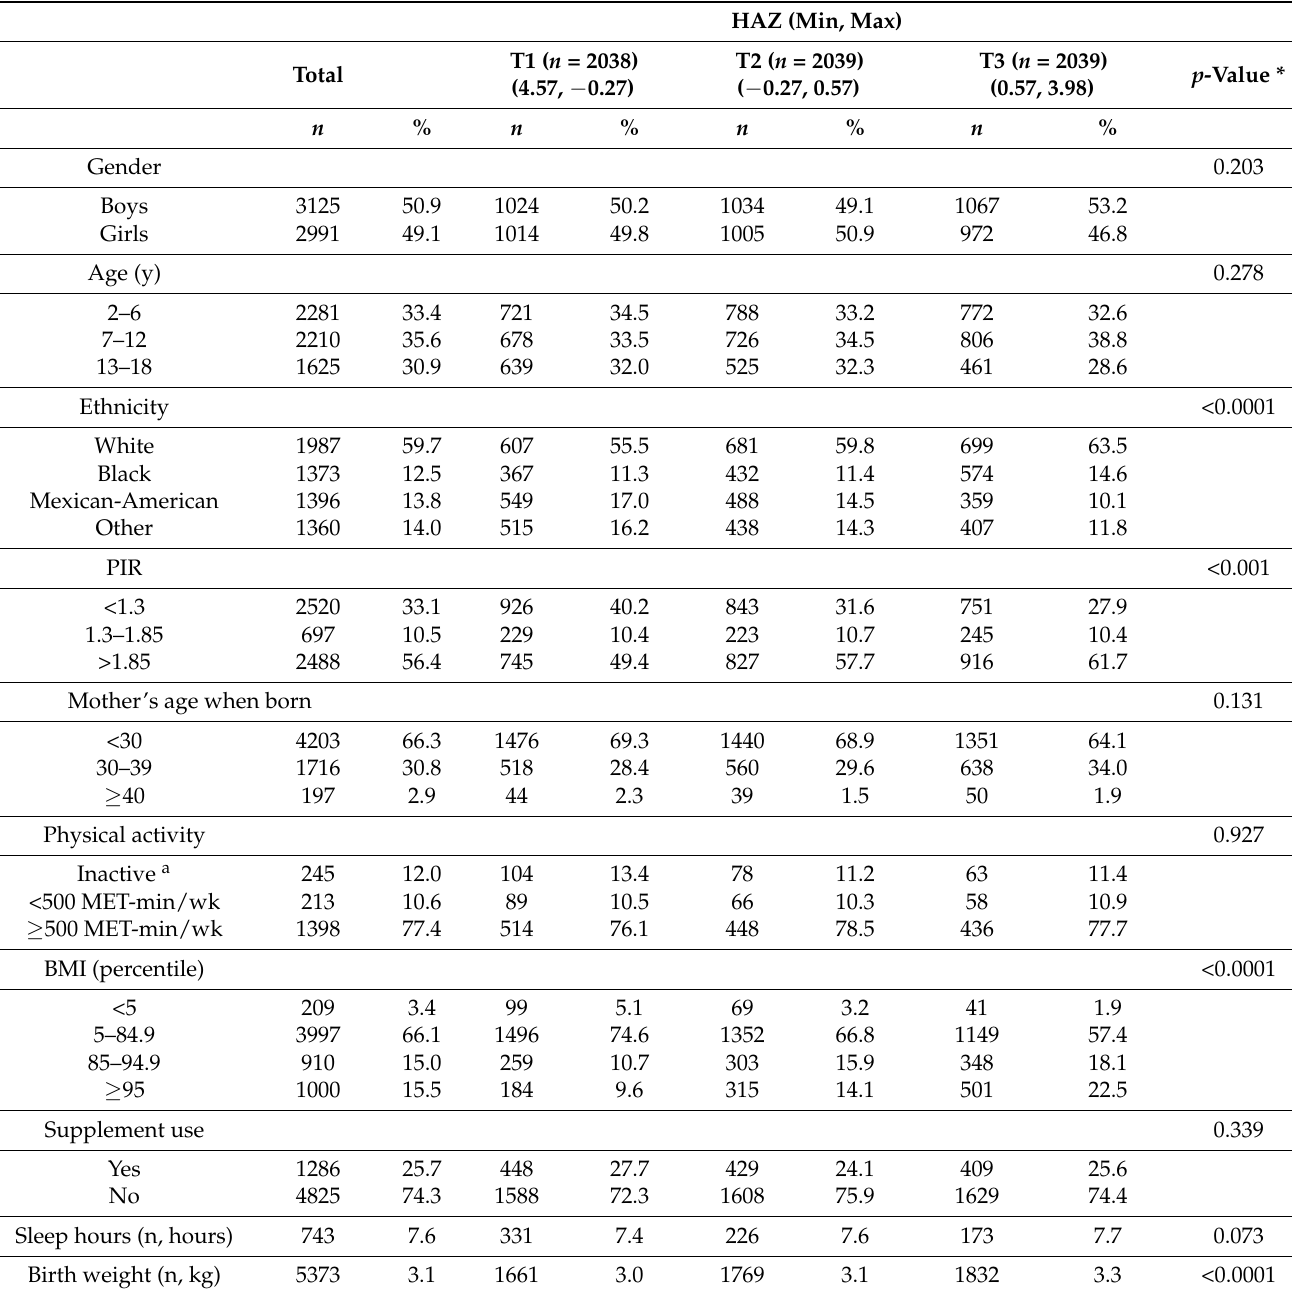
Table 1. Sociodemographic and lifestyle characteristics by tertile of HAZ among US children aged 2–18 years in NHANES 2007–2014 ( n =